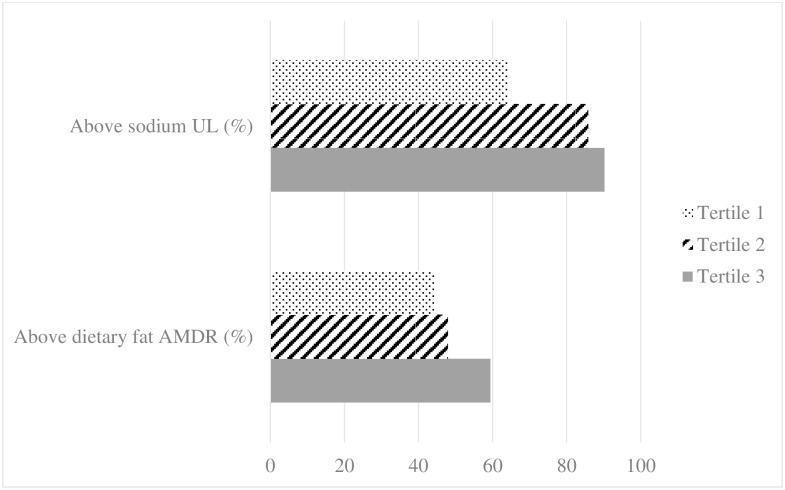
The percentages of individuals with above recommended levels of dietary fat and sodium across tertilesa.a Daily dietary fat beyond the Acceptable Maconutrient Distribution Range(AMDR)(20%–35%) in tertile 1, tertile 2 and tertile 3, P = 0.054; daily sodium intake beyond the Tolerable Upper Intake Levels (2300 mg/fay) in tertile 1, tertilr 2 and tertile 3, P<0.0001.